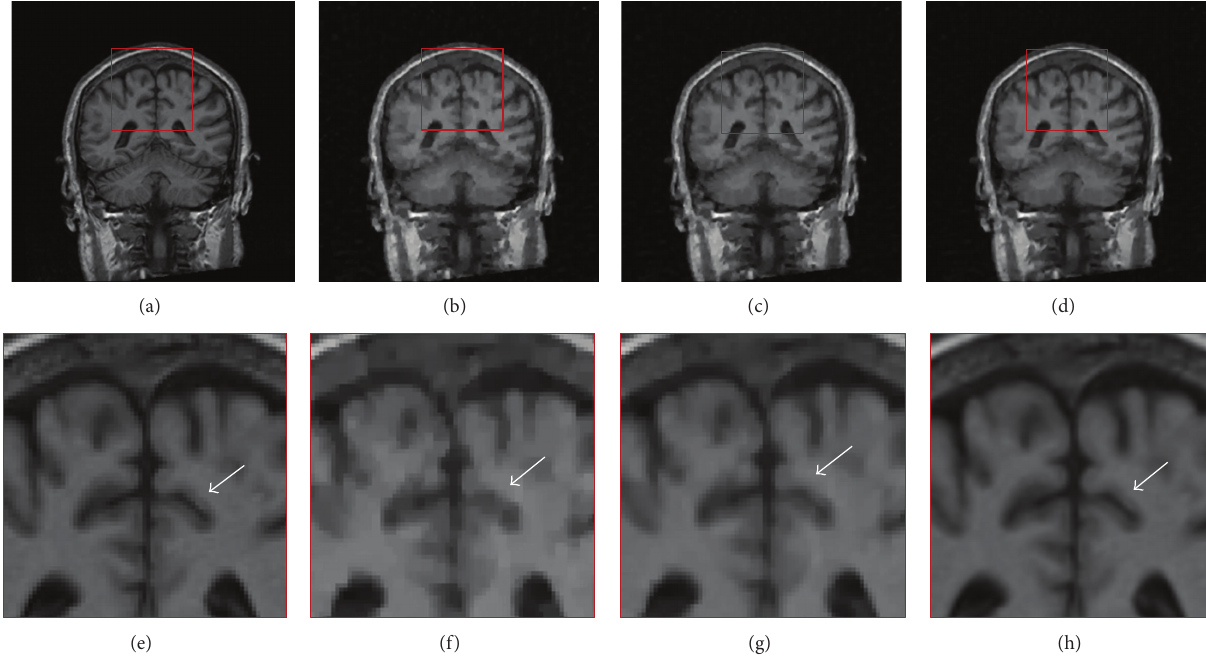
Figure 11: Original coronal brain image and experimental results. (a) Original coronal brain image. Reconstruction at sampling rate 0.25 by (b) CS; (c) CS DT-CWT; (d) iCS technique; (e), (f), (g), and (h) are detail views of region outlined by arrow in (a), (b), (c), and (d),